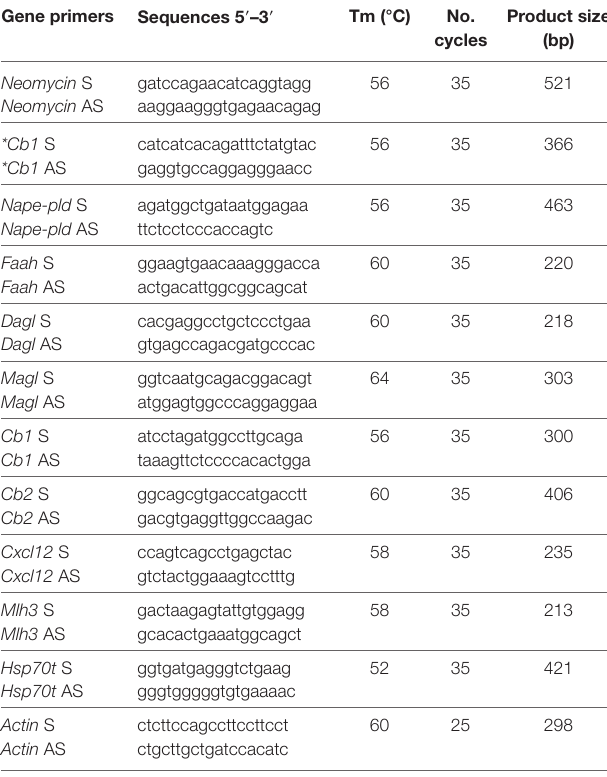
TaBle 1 | Primer sequences (S: sense; AS: antisense), annealing temperature (Tm) and cycles number used to analyse testicular levels of Nape-pld , Faah